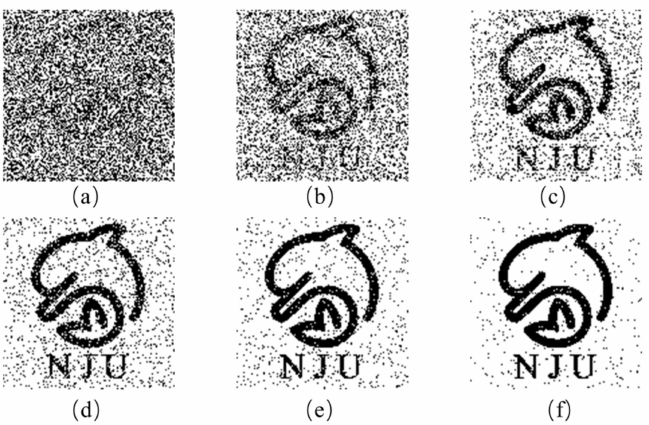
Figure 6. Extracted watermark patterns after JPEG compression (QF = 30) with a QF of 30, when F was set as 20, 28, 36, 44, 52 and 60 ( a – f